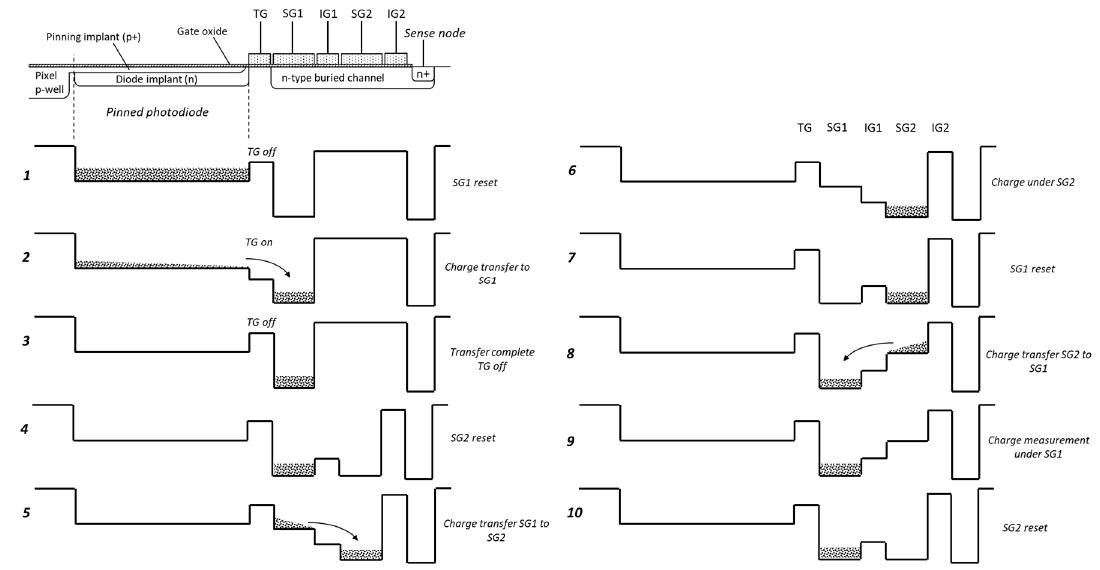
Figure 2. Timing diagram of the charge transfer in the proposed pixel.